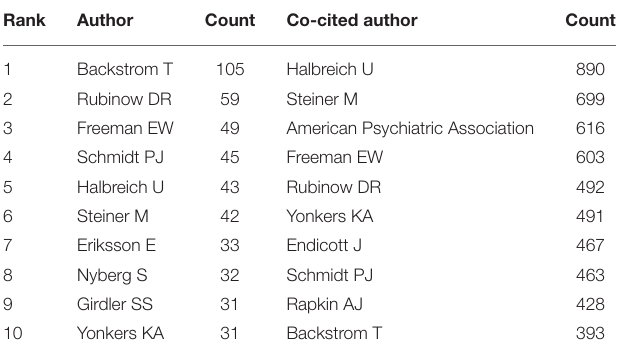
TABLE 4 | The top 10 active authors with publications on PMS/PMDD research from 1995 to 2018.